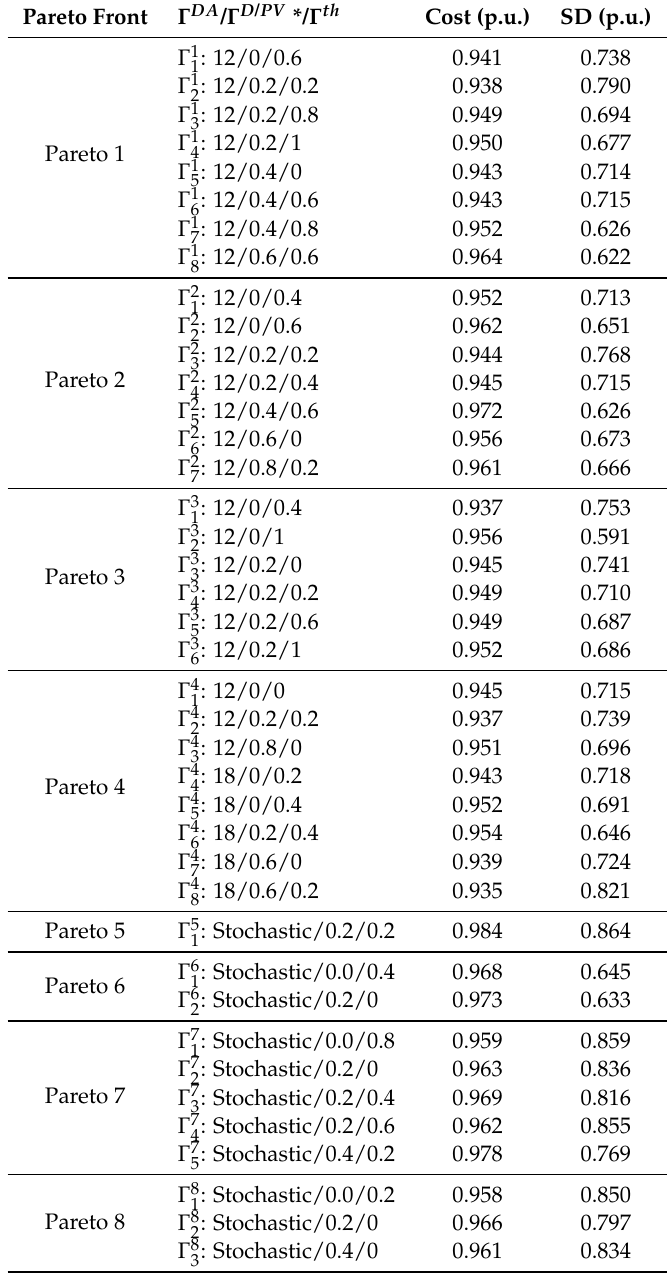
Table 1. Details of the Pareto front values and improvements with respect to the deterministic solution. * Γ D is valid for the unified approach, and Γ PV is valid for the separated